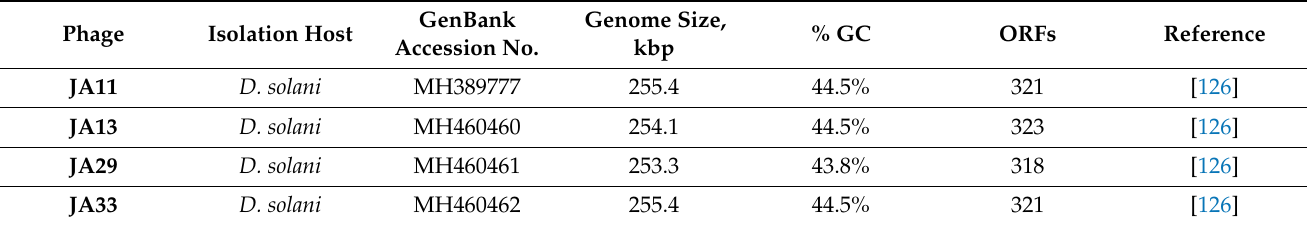
Table 4. Genomic properties of Salmondvirus bacteriophages infecting